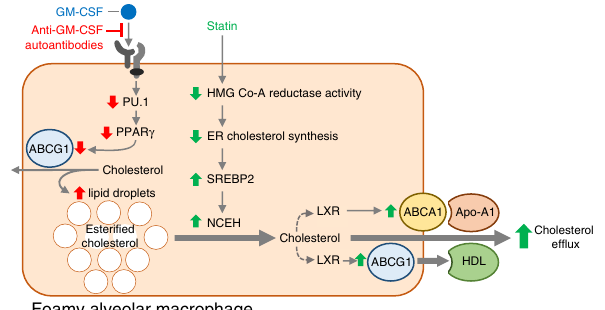
Fig. 4 Proposed mechanisms for the pathogenesis and statin therapy of PAP. In the absence of GM-CSF signaling, surfactant-derived cholesterol accumulates progressively in lipid droplets resulting in foamy alveolar macrophages (red arrows indicate the effects of reduced GM-CSF signaling). Statin therapy results in increased cholesterol clearance from macrophages in PAP (green arrows represent the effects of statin in foamy alveolar